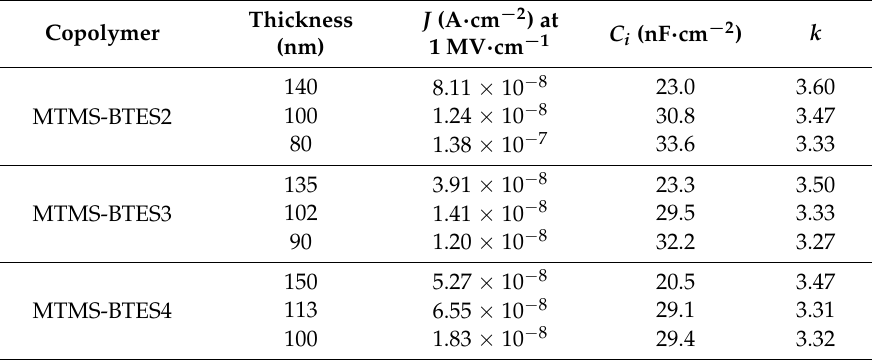
Table 1. Properties of Copolymer Dielectrics based on MIS Device Structure ( J , leakage current density; C i , Capacitance; k , dielectric